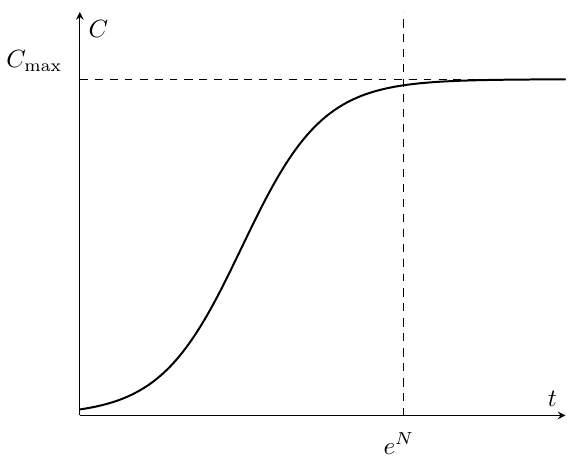
Figure 1. A sketch of the time evolution of the complexity C ( t ) of a random quantum